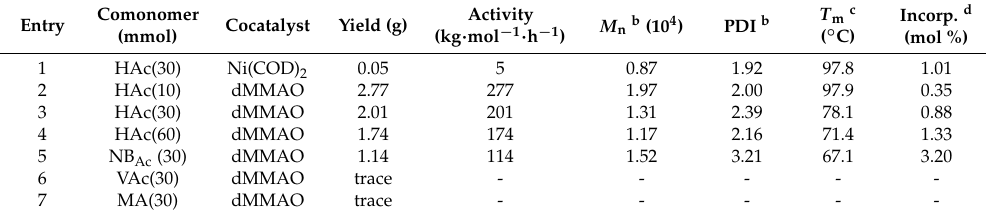
Table 2. Copolymerization of ethylene with polar monomers using complex C2 a .